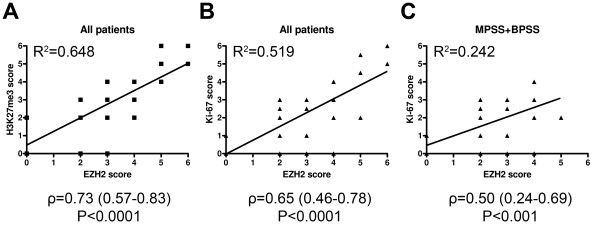
Scatter graphs with linear trend lines indicate positive correlations between EZH2 and the other markers. All patients were included in (A) and (B), while PDSS patients were excluded in (C). Spearman’s r (ρ) and coefficient of determination (R2) values are shown at the bottom.